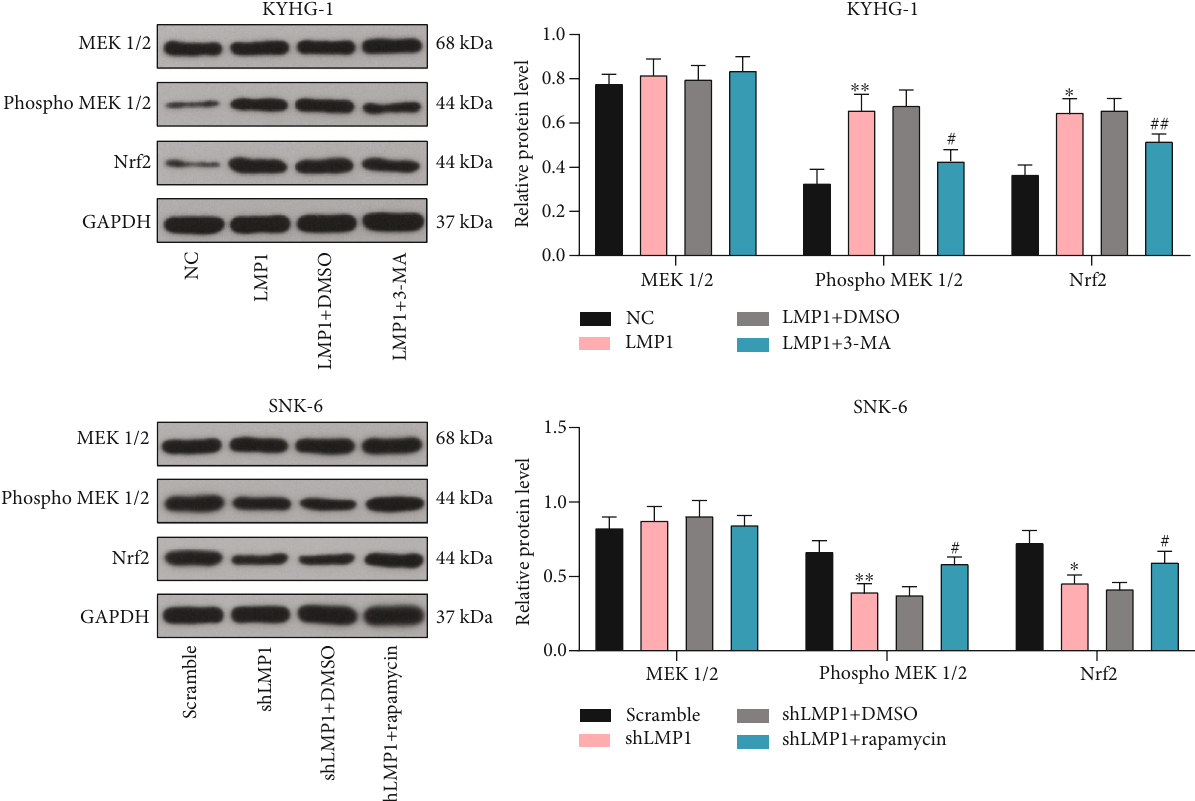
Figure 4: Overexpression of LMP1 activates the MEK1/2/Nrf-2 signaling pathway. The expression of the MEK1/2/Nrf-2 signaling pathway was detected by western blot analysis. All data are displayed in the form of mean ± standard deviation . Two-way ANOVA and Tukey ’ s multiple comparison test are used to test the signi fi cant di ff erence of data. ∗ , # p < 0 : 05 , ∗∗ , ## p < 0 : 01